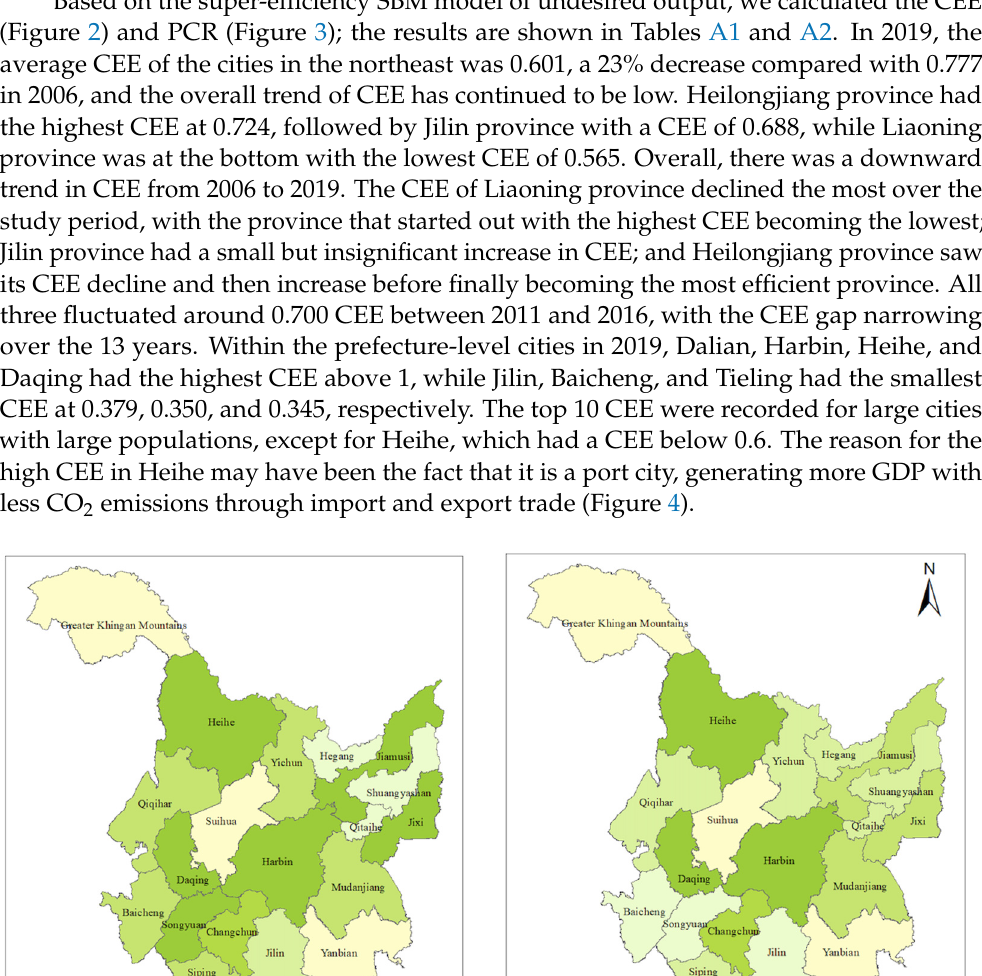
Figure 3. Potential carbon dioxide emission reduction (PCR) of prefecture–level cities in northeast China.